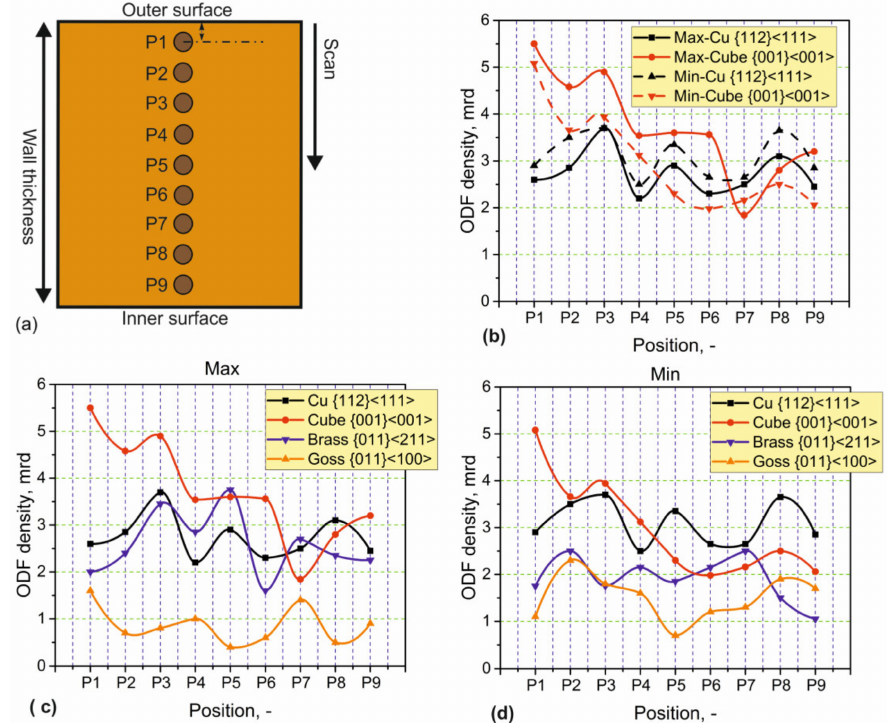
Figure 10. ( a ) Reference points over the wall thickness of the as-received tube. ( b ) Variation of the cube and Cu components at max and min positions of the initial tube. ( c ) Max and ( d ) min position comparison of the four principal